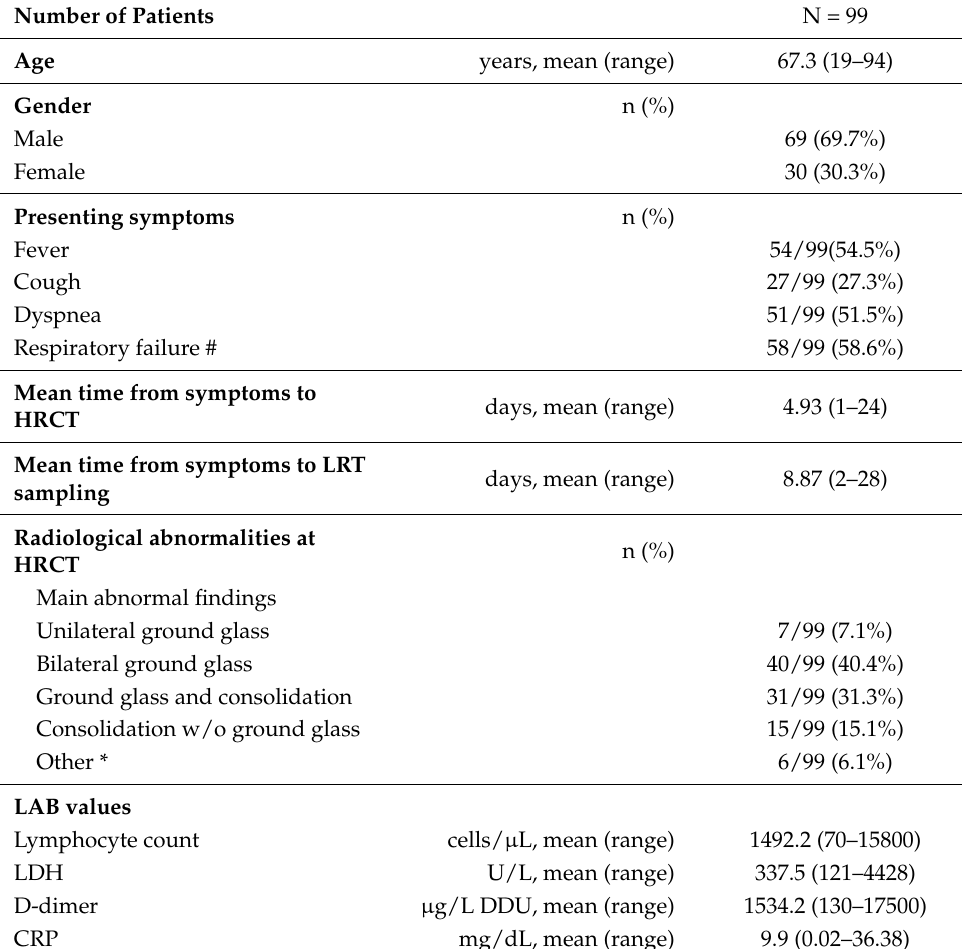
Table 1. Main characteristics of patients with clinical suspicion of COVID-19 who underwent lower respiratory tract (LRT) sampling. # respiratory failure was defined as PaO2 <60 mmHg in ambient air or SpO2 <94% in ambient air. * includes: no alterations, emphysema, tree-in-bud, interstitial thickening with reticular pattern, pleural effusion. ** N.3 patients underwent both BNTA and BW. *** calculated including all screened